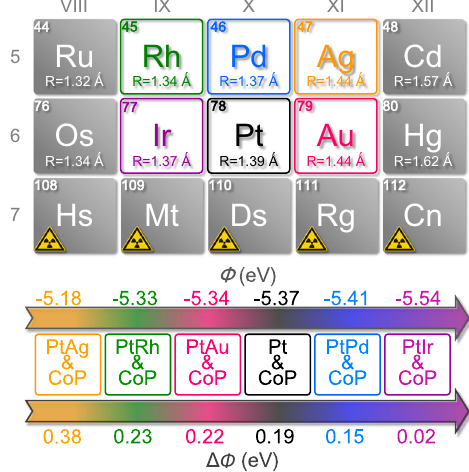
Fig. 2 Catalyst Design. Design of PtM/CoP model catalysts with the controllable Δ